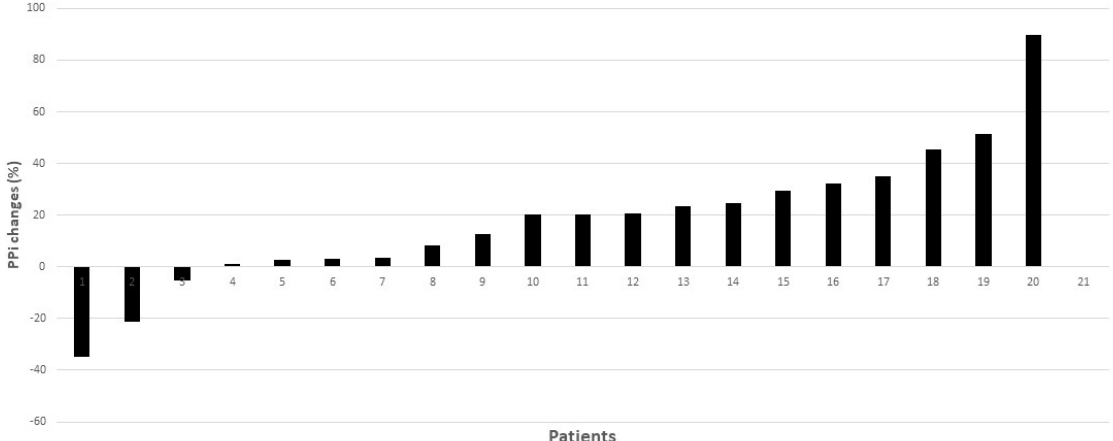
Figure 3. Individual percentage changes in PPi, comparing the end of the placebo phase and the end of the lansoprazole phase. 20.2%